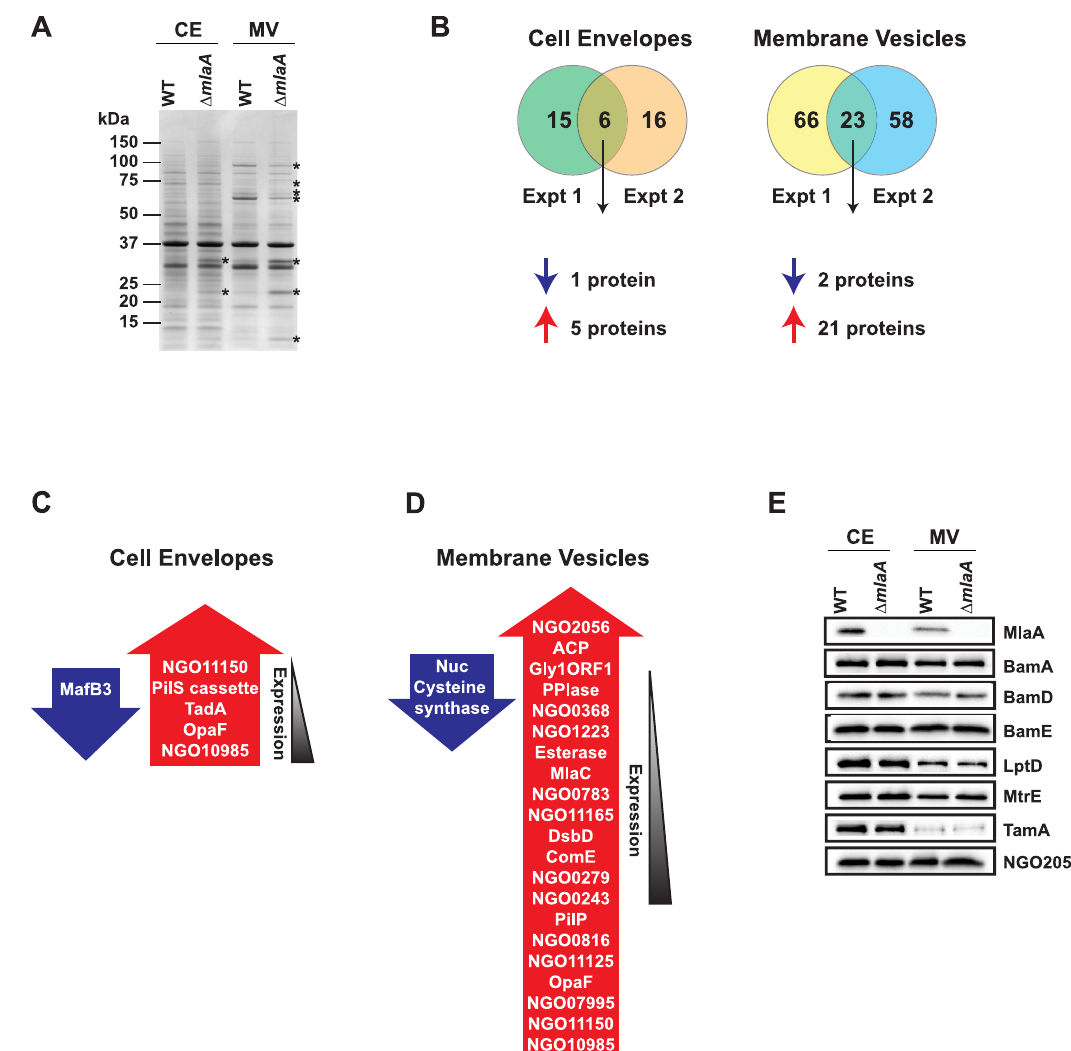
Fig 9. Proteomic investigations of MlaA influence on cell envelope and membrane vesicles. (A) CE and MV fractions isolated from WT FA1090 and isogenic knockout Δ mlaA were normalized based on protein concentration, separated by SDS-PAGE, and proteins were visualized by coomassie staining. The migration of a molecular weight marker is shown on the left in kDa. Proteins that appeared differentially abundant in the Δ mlaA mutant by visual inspection are labeled with an asterisk. (B) Trypsinized CE and MV proteins from WT and Δ mlaA were labeled with TMT6plex isobaric mass tags, fractionated by strong cation exchange and reverse phase chromatography, and subjected to peptide identification by tandem mass spectrometry. The number of differentially abundant proteins in the Δ mlaA CE or MV protein profiles is noted in the Venn diagrams. (C, D) Lists of differentially abundant proteins in the CE (C) or MVs (D) of the Δ mlaA mutant. Proteins in blue arrows are downregulated in the mutant, while those listed in red arrows are upregulated in the mutant. Proteins are arranged by the magnitude of the mutant:WT ratio. (E) Validation of quantitative proteomics results. CE and MV fractions from WT FA1090 and Δ mlaA were normalized by protein concentration, separated by SDS-PAGE, and probed with antisera against indicated proteins. SDS-PAGE, sodium dodecyl sulfate-polyacrylamide gel electrophoresis; TMT, tandem mass tag.